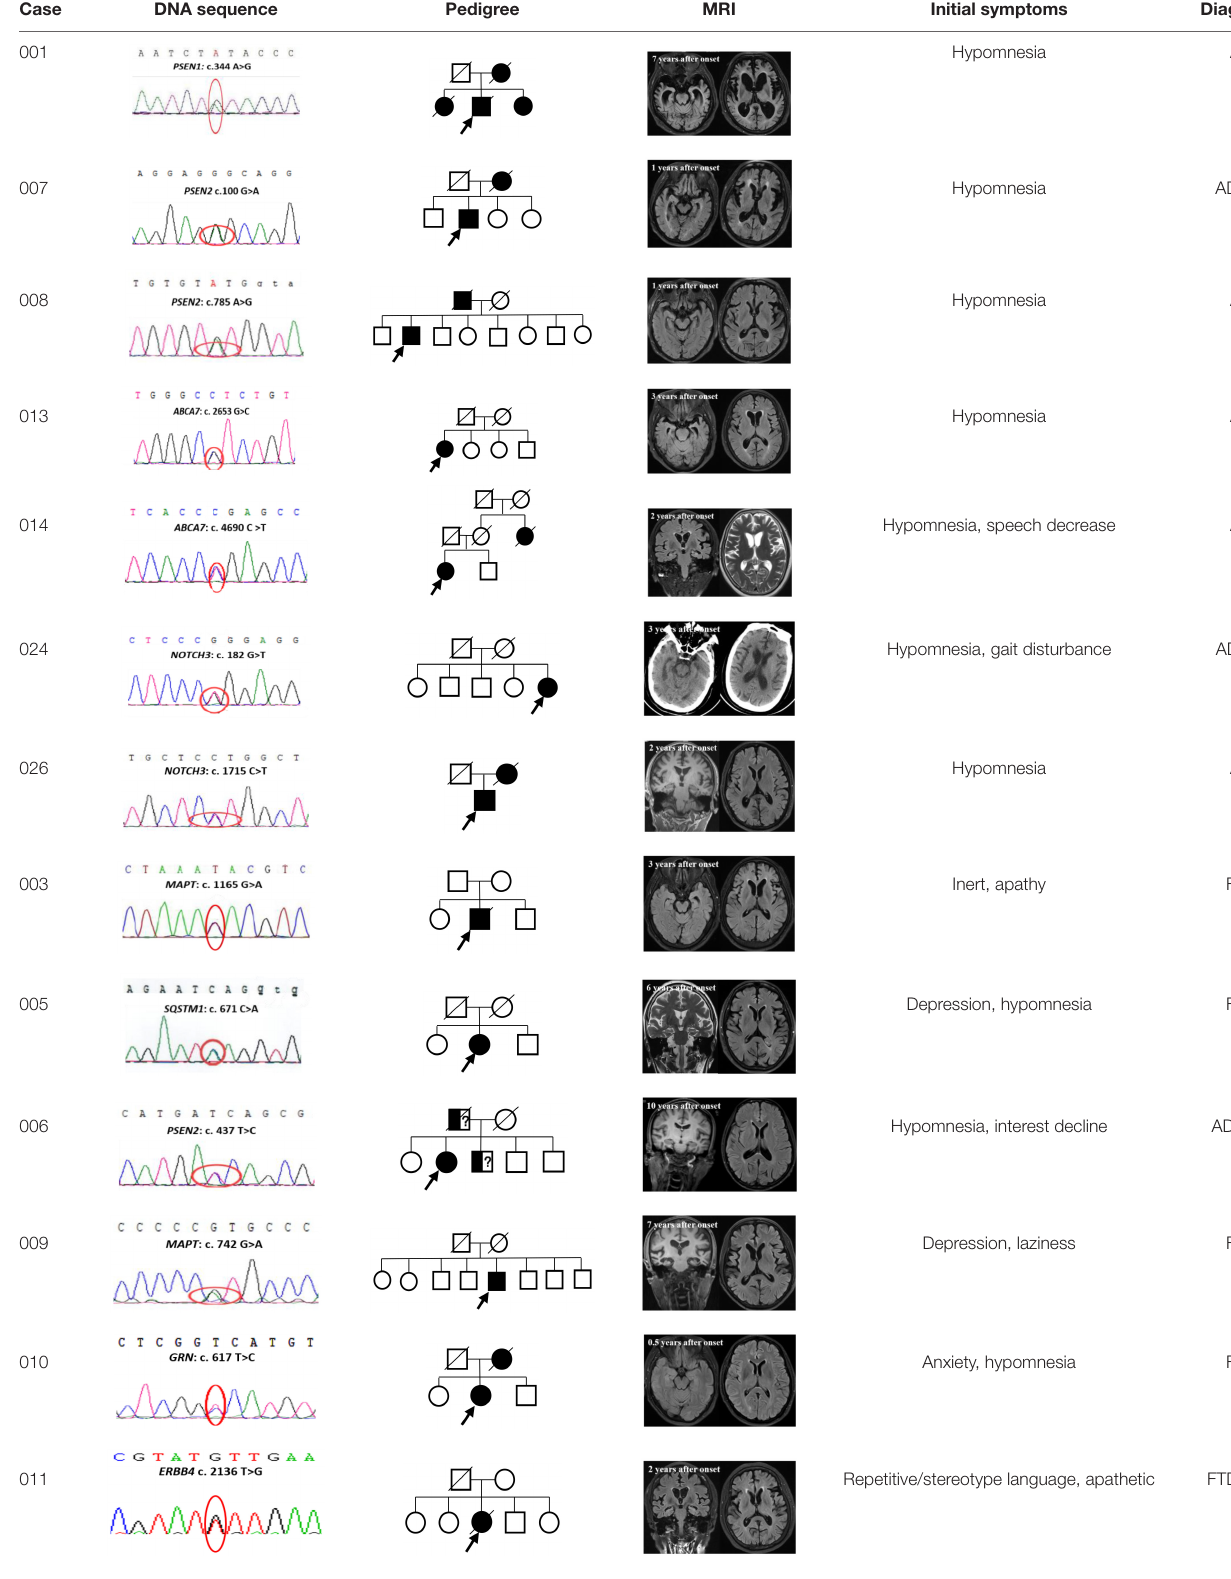
TABLE 3 | DNA sequence, brain MRI or CT, pedigree, initial symptoms, and clinical diagnosis of dementia patients with variants. Case DNA